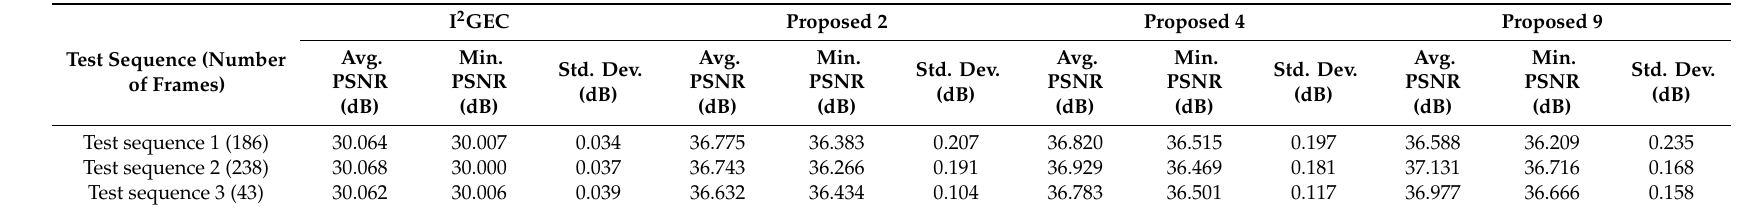
Table 1. Average and minimum PSNRs for the proposed and benchmark methods.